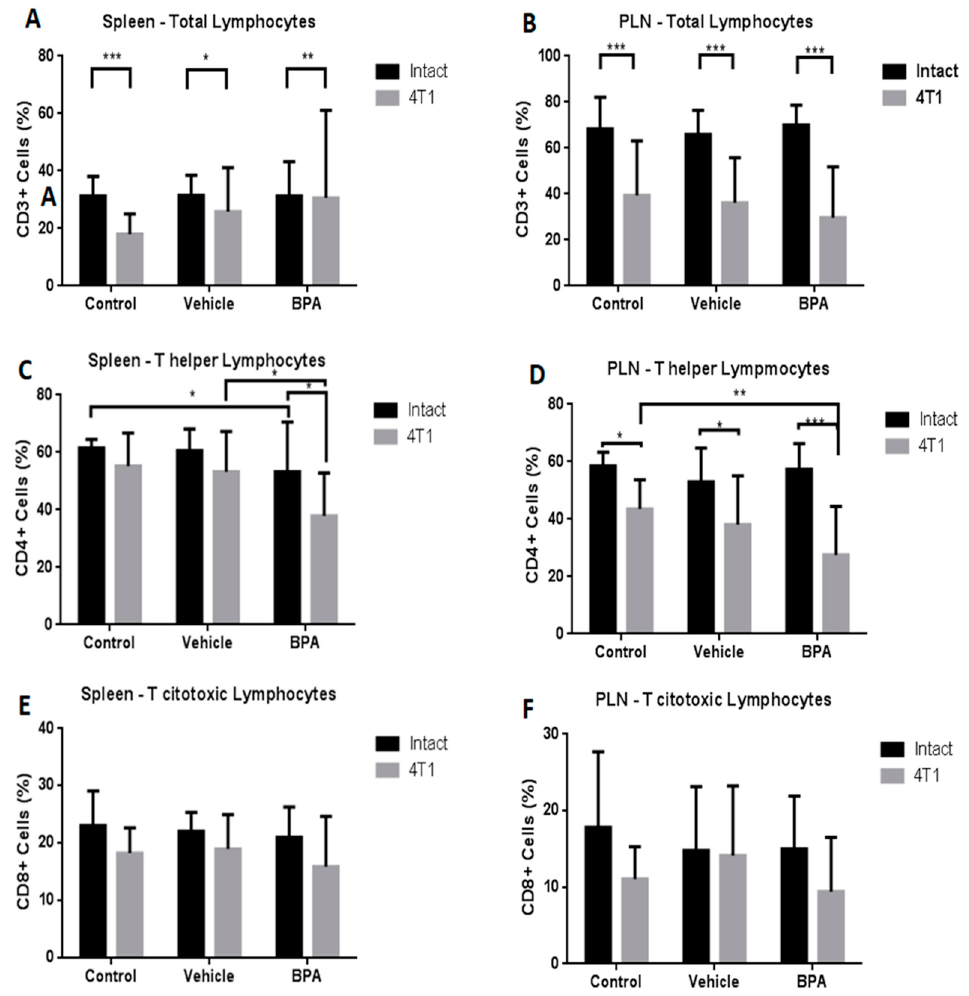
Figure 4. Percentages of T cell subpopulations in the spleen and peripheral lymph nodes (PLN) in the offspring of BPA treated mice. Total lymphocytes (CD3+) ( A , B ), T helper cells (CD4 + ) ( C , D ) and T cytotoxic cells (CD8 + ) ( E , F ) in control ( n = 7), vehicle ( n = 6), vehicle/4T1 ( n = 7), BPA ( n = 7) and BPA/4T1 ( n = 7) mice. The data shows the mean and standard deviation of the population percentage (* p < 0.05, ** p < 0.01 and *** p < 0.001).